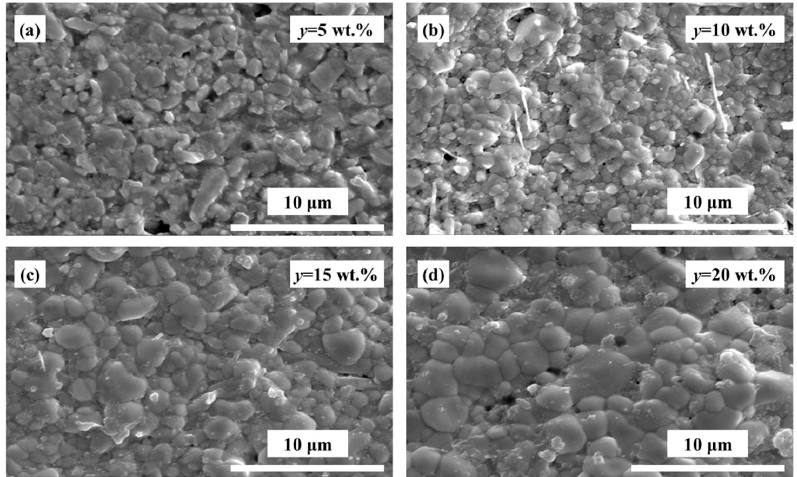
Figure 2. Scanning electron microscopy (SEM) images of the surface morphology for as-grown BTS 0.105 - y BZN ceramics ( a ) y = 5 wt %; ( b ) y = 10 wt %; ( c ) y = 15 wt %; ( d ) y = 20 wt %.